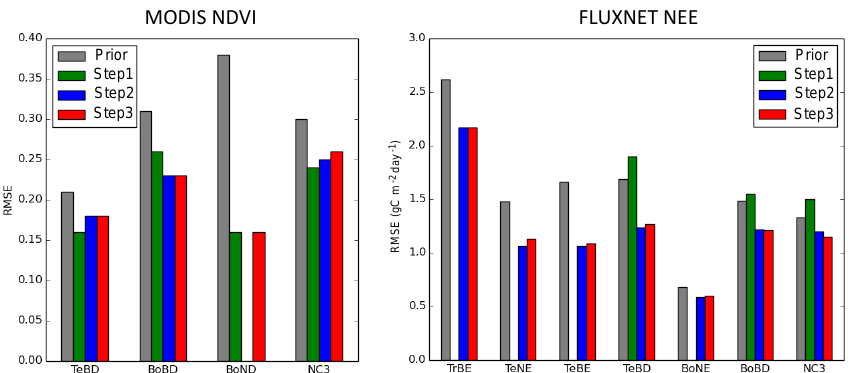
Figure 8. RMSE between model outputs and observations for two types of observations: MODIS-NDVI on the left and FluxNet-NEE on the right, for different plant functional types (PFT: TrBE, TeNE, TeBE, TeBD, BoBD, BoND, NC 3 ) and for the prior model simulation and the posterior of each step of the assimilation framework. Missing bars correspond to the fact that no data were available to constrain a given